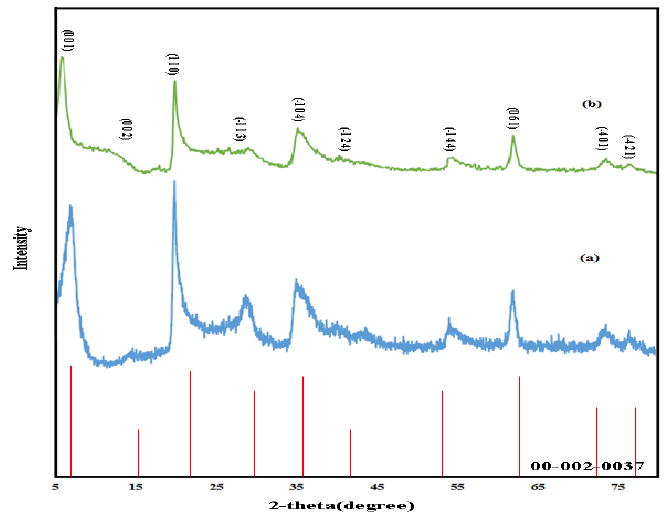
Fig. 2. XRD patterns of raw (a) and activated nanobentonite